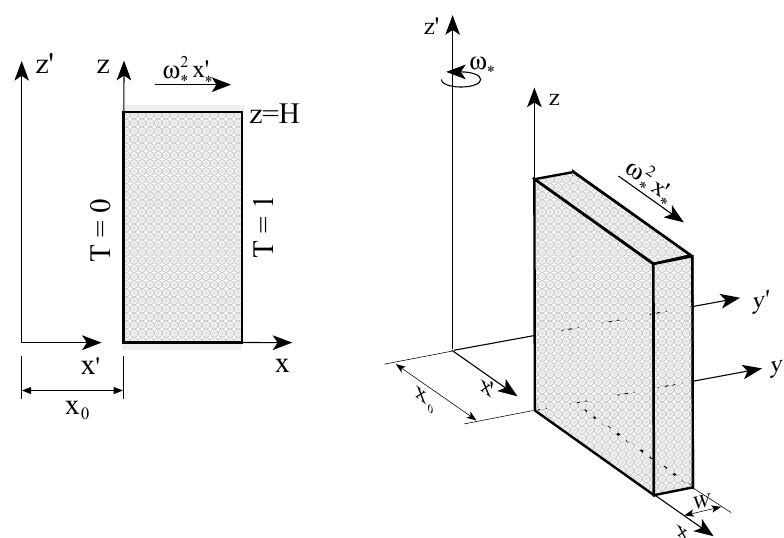
Figure 4. A rotating fluid saturated porous layer distant from the axis of rotation and subject to different temperatures at the sidewalls. (Reprinted from [40], with permission from Springer.)